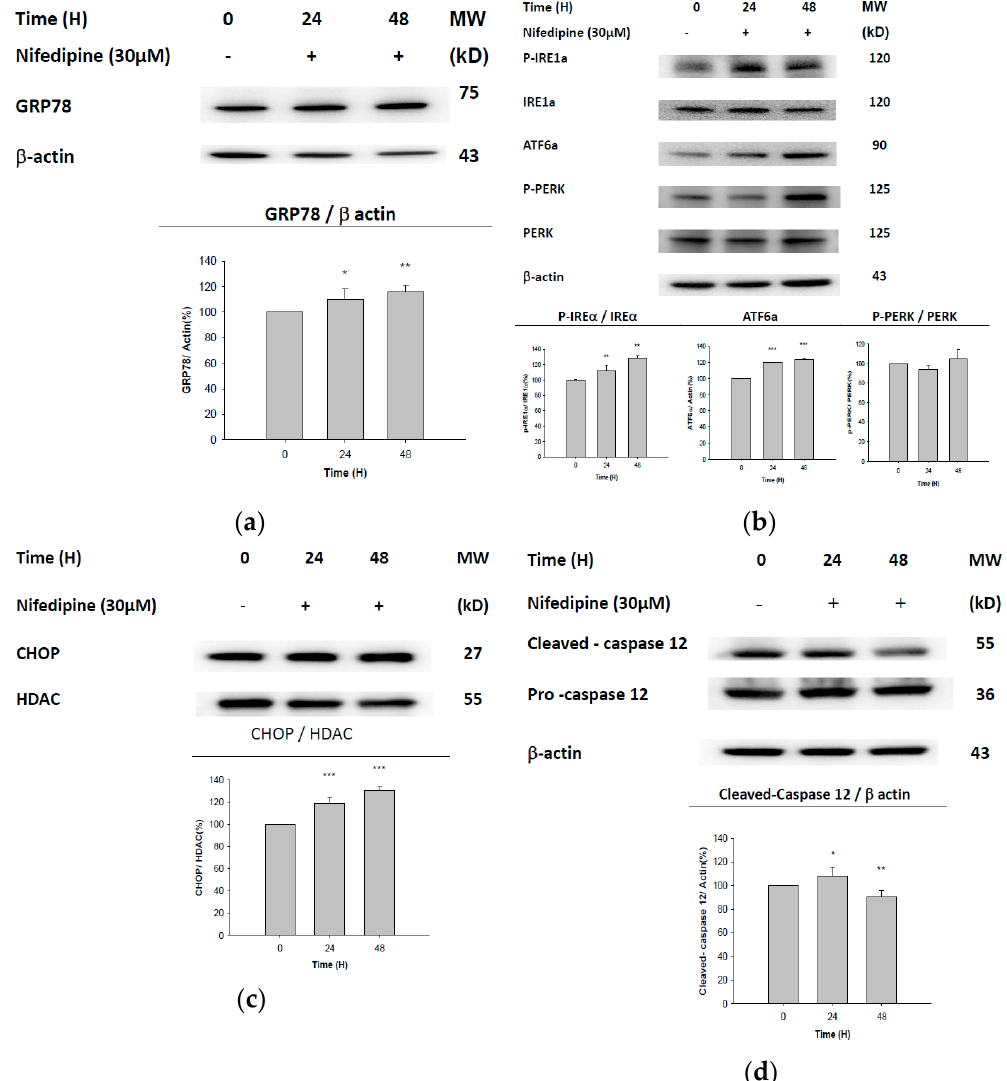
Figure 2. Representative Western blot and quantification of unfolded protein response (UPR)- endoplasmic reticular (ER) stress-related proteins elicited in NRK52E cells treated with nifedipine for 0 – 48 h. ( a ) Glucose-regulating protein, 78 kDa (GRP78); ( b ) phosphorylated (p)-inositol-requiring